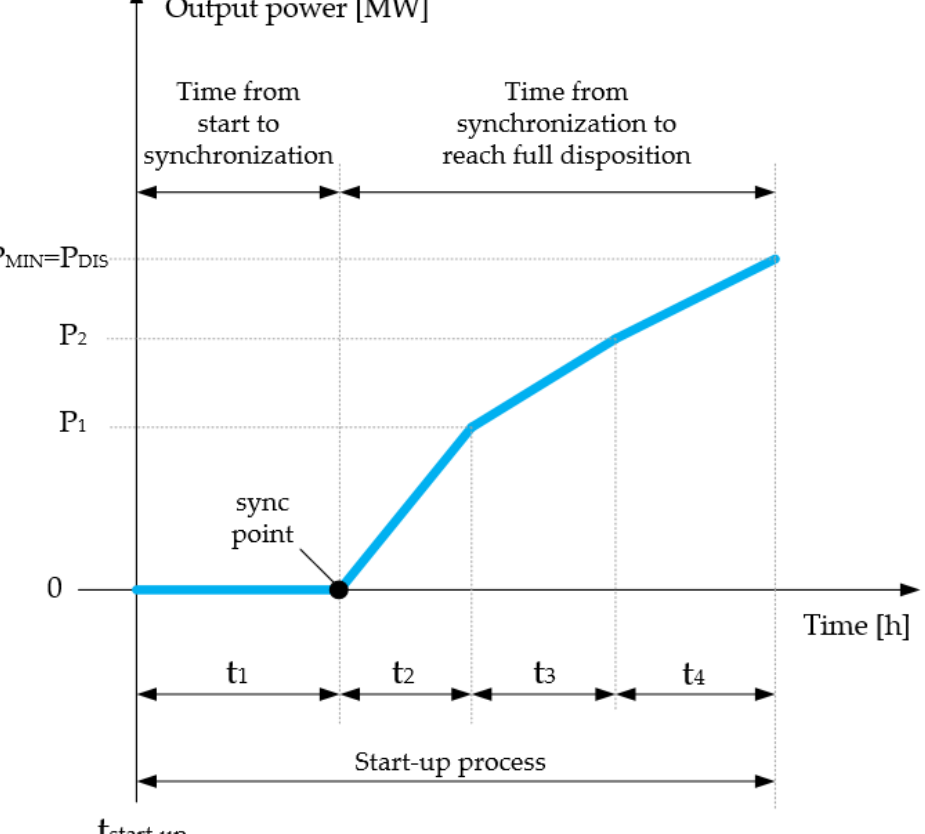
Figure 3. The assumed start-up characteristic of power generating units, where: tstart-up—the time when the start-up begins; t 1–4 —characteristic times related to the warming up processes; when the start-up begins; t 1 –t 4 —characteristic times related to the warming up processes; P 1 –P 2 — P1-2—characteristic values of output power related to the warming up processes; characteristic values of output power related to the warming up processes; PMIN = PDIS—minimum PMIN=PDIS—minimum output power of a given power generating unit. Own development based output power of a given power generating unit. Own development based on on [26–28].